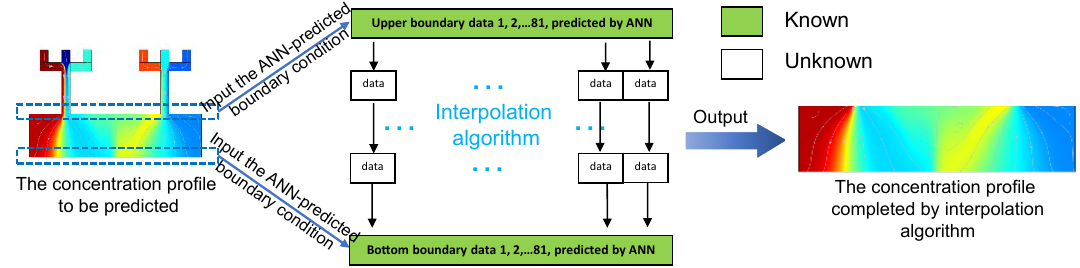
Figure 4. The flowchart of completing the unknown data points of the reactive region based on the linear interpolation